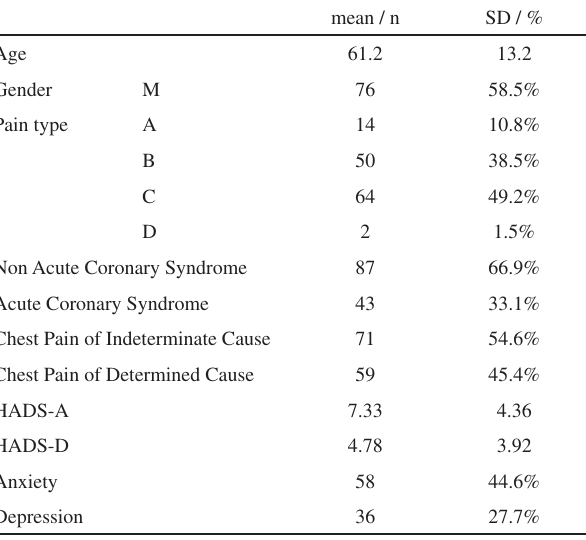
Table 1 - Demographic and clinical characteristics